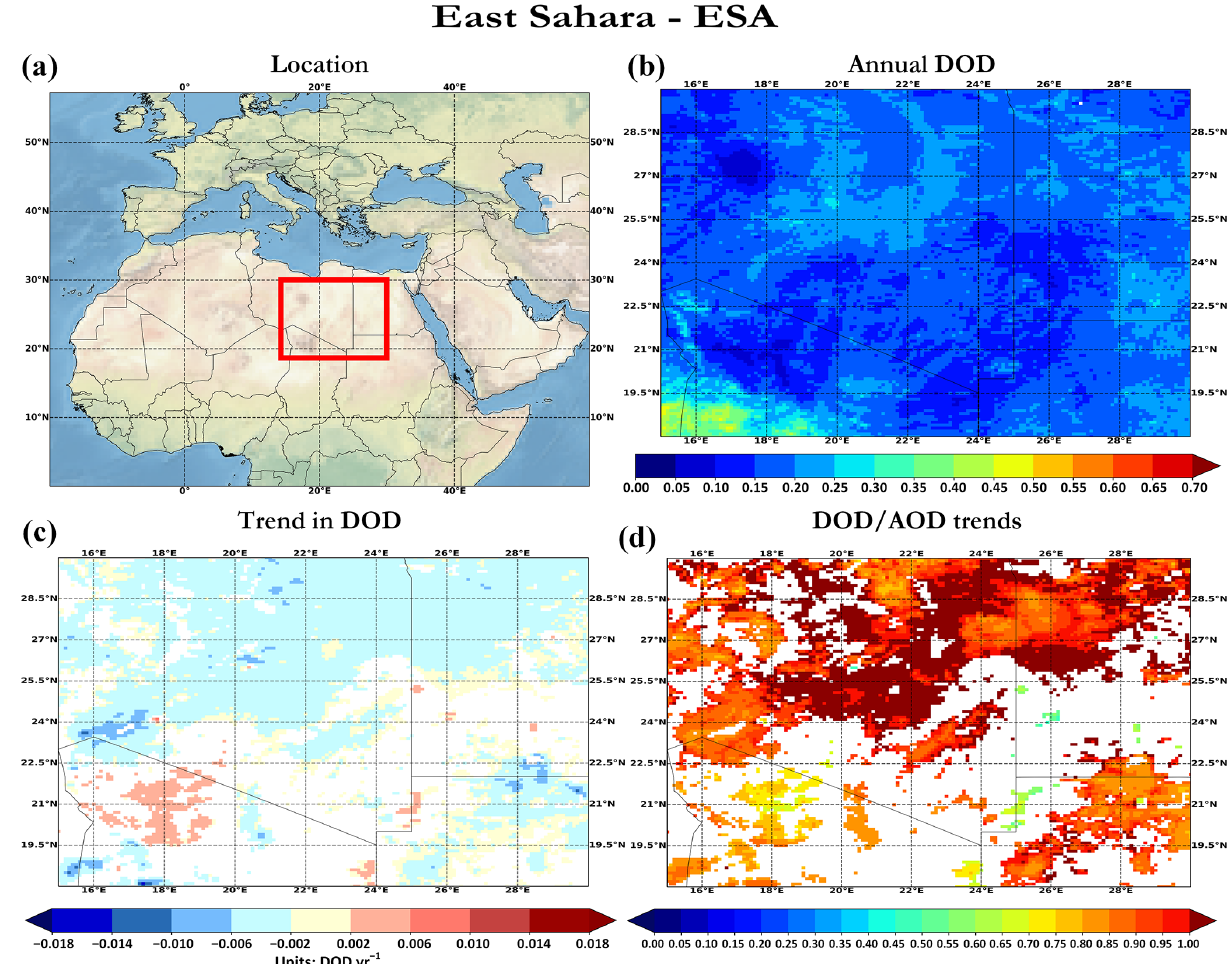
Figure 12. Same as Fig. 10, but for the eastern